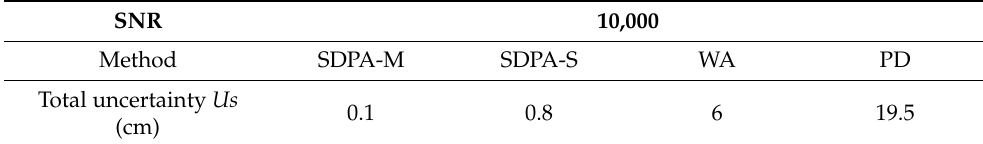
Table 3. Total estimated uncertainty of selected methods, results of simulations; SNR = 10,000. SNR 10,000 Method SDPA-M SDPA-S WA PD Total uncertainty